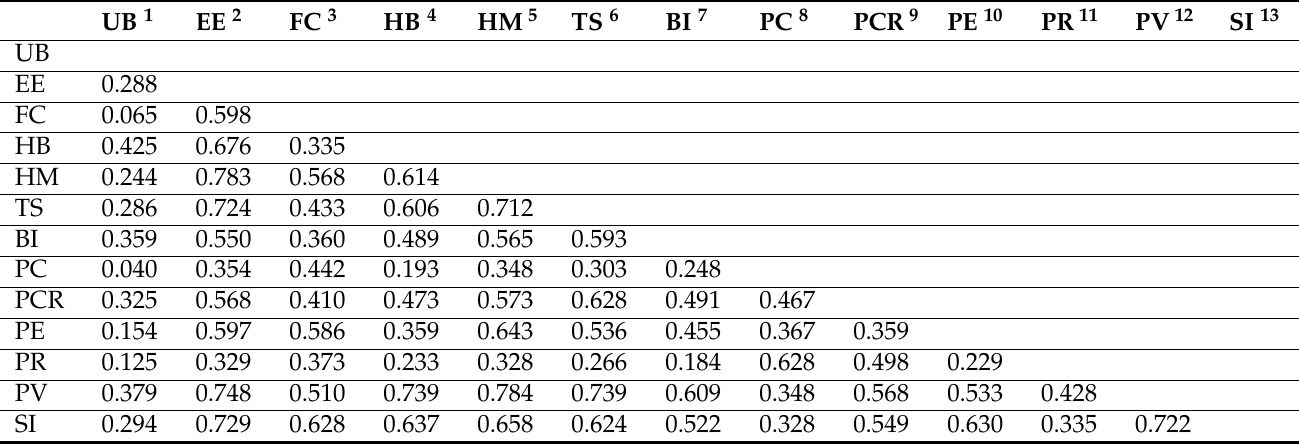
Table 3. Heterotrait-Monotrait Ratio